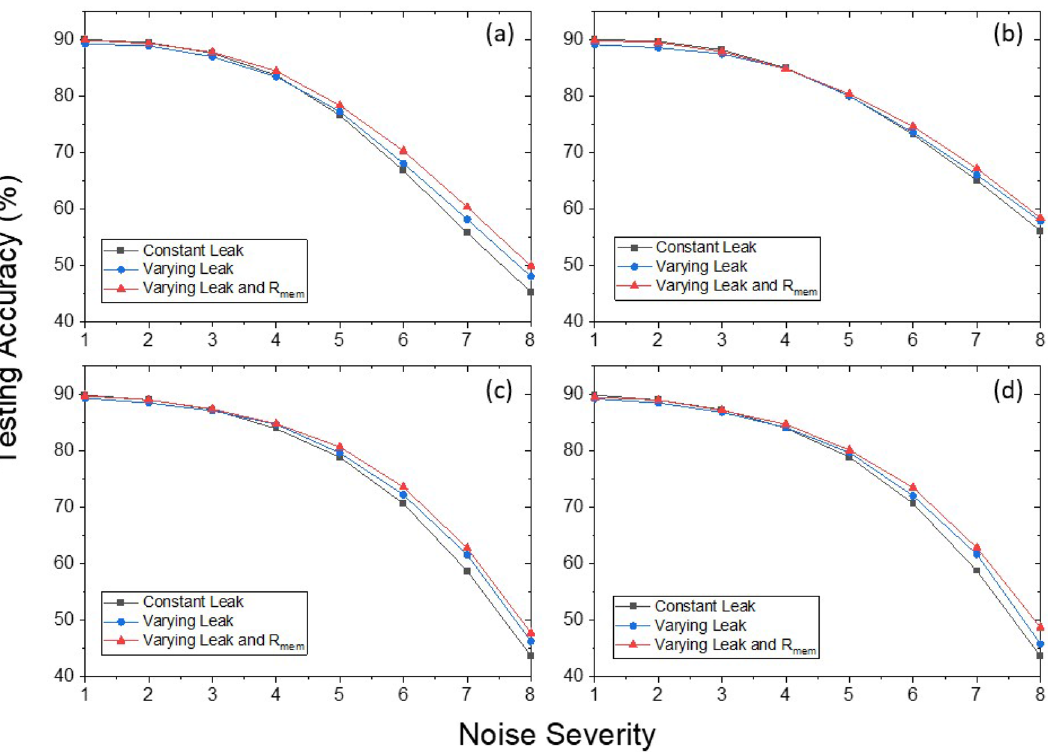
Figure 6. Testing accuracy vs noise severity Spiking VGG9 on Cifar10. ( a ) Gaussian noise injected to input before Poisson spiking train generation (scenario-1). ( b ) Gaussian noise injected after Poisson spiking train generation (scenario-2). ( c ) Impulse noise injected to input before Poisson spiking train generation (scenario-1). ( d ) Impulse noise injected after Poisson spiking train generation